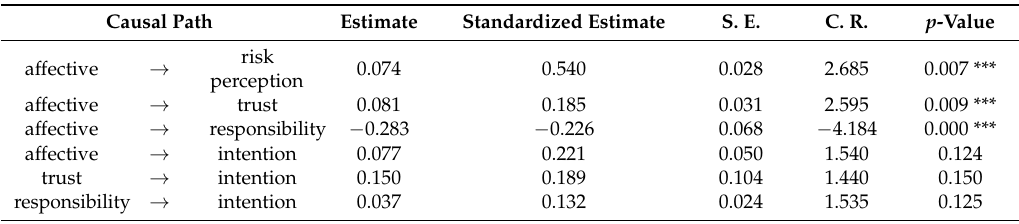
Table 5. The result of regression